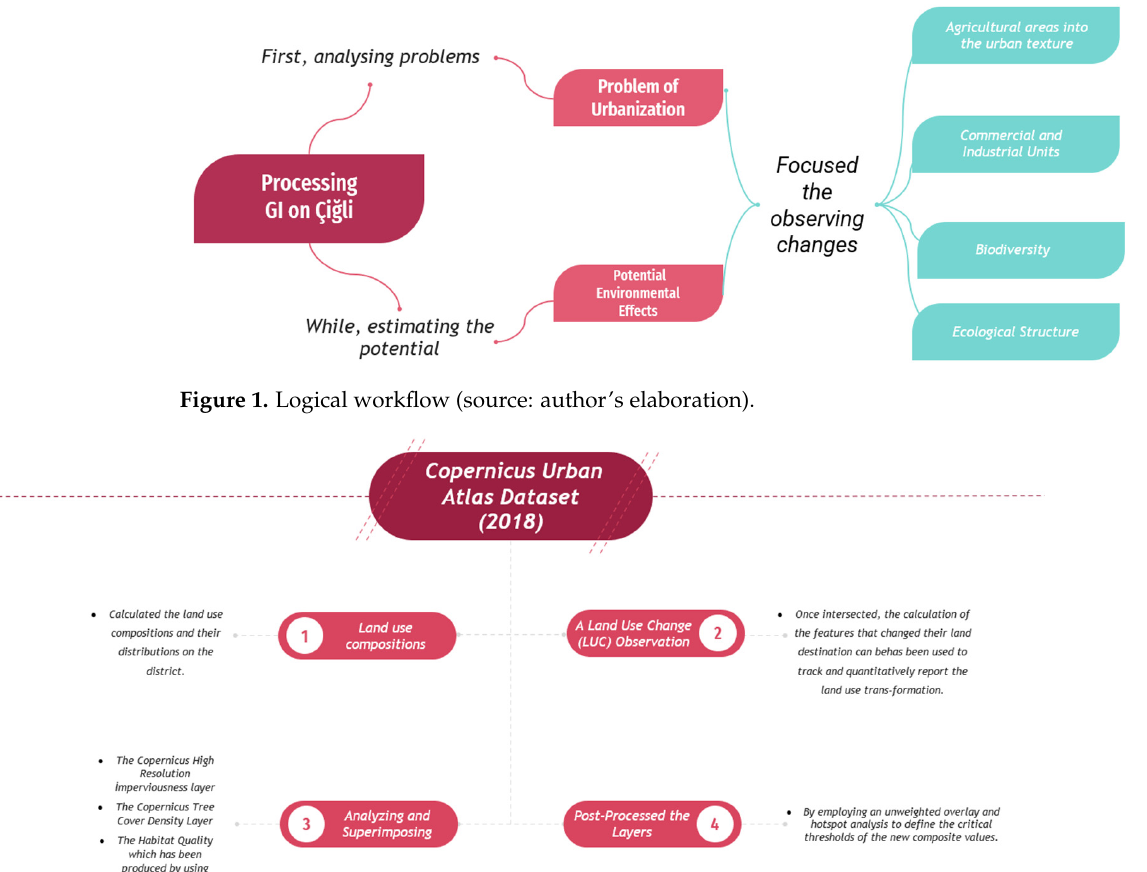
Figure 2. Analytical workflow of the GIS processing phases (source: author’s elaboration).